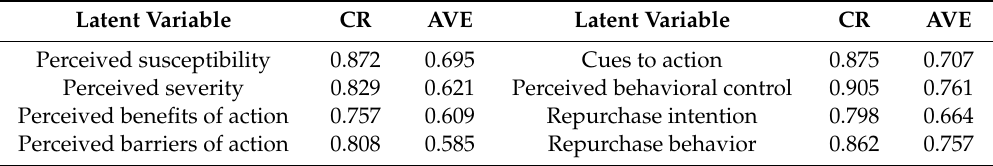
Table 3. Composite reliability (CR) and average variance extracted (AVE) values of constructs.